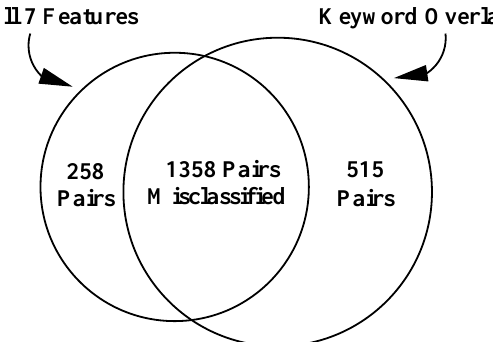
Figure 2: Venn diagram of classification errors, comparing errors made by a classifier with the best single feature ( keyword overlap ) with the errors made by classifier using all the features. The overlapping proteins are misclassified by both sets of features. Those that are misclassified by keyword overlap , but are correctly classified by the inclusion of additional computable features are of potential interest as annotation knowledge